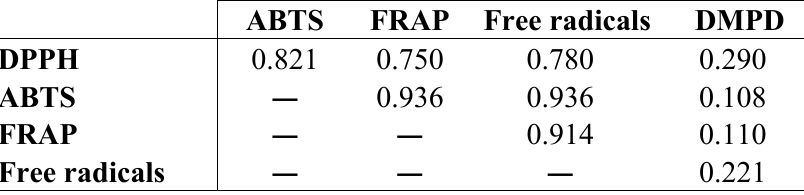
Table 2. Values of correlation coefficients for